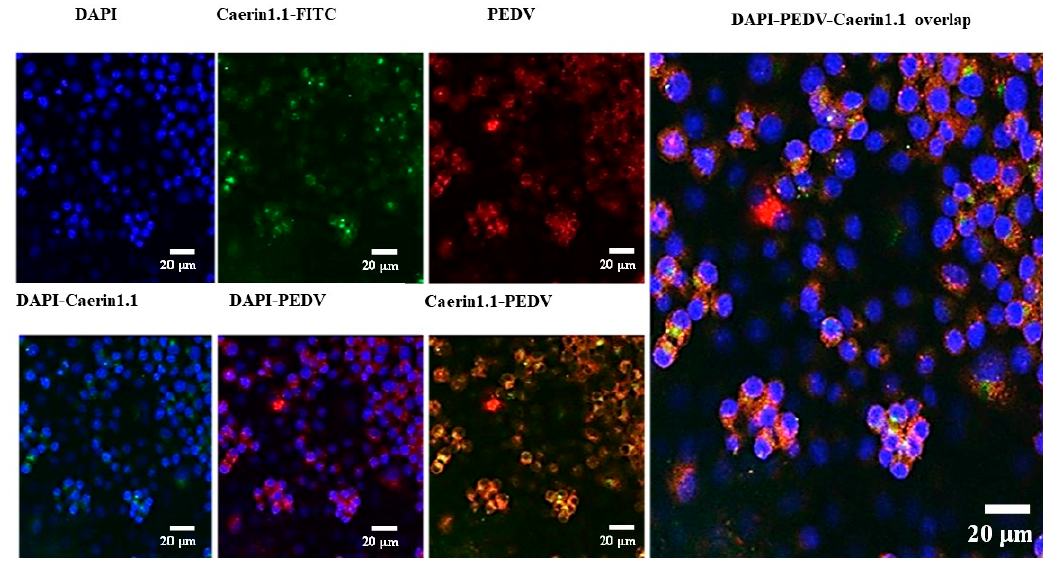
Figure 6. The interaction between Caerin1.1 and porcine epidemic diarrhea virus (PEDV). Confocal microscope. Vero cells were treated with fluorescein isothiocyanate (FITC)-Caerin1.1 (100 μ g/mL), PEDV (200 pfu), or FITC-Caerin1.1 (100 μ g/mL) and PEDV (200 pfu) separately, which were incubated with Vero cells for 12 h at 37 °C. Caerin1.1 were immunostained with FITC (green). The PEDV infection was detected with the monoclonal antibody against PEDV S protein (red) and cell nuclei were counterstained with 4 ′ ,6-diamidino-2-phenylindole (DAPI) (blue). Scale bar, 20 μ m.